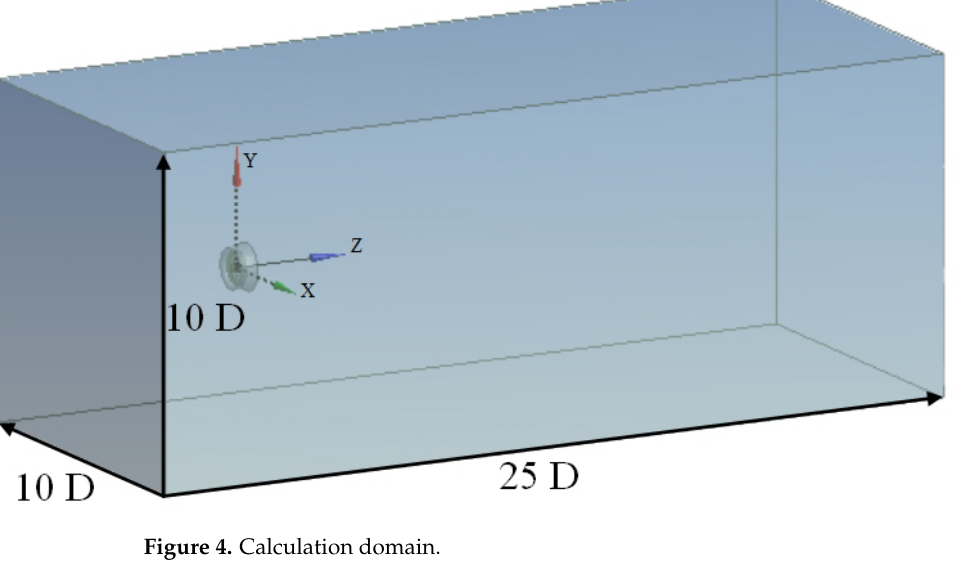
Figure 4. Calculation